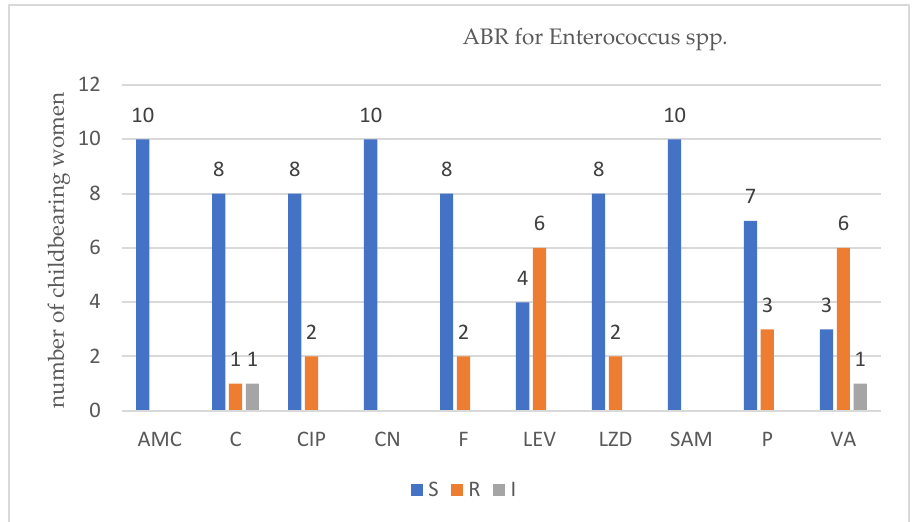
Figure 3. Profile of antibiotic resistance for Enterococcus spp.; S = sensitive, I = intermediate; R = resistant. Legend: ampicillin/sulbactam (SAM), amoxicillin/clavulanic acid (AMC), ciprofloxacin (CIP), chloramphenicol (C), gentamycin (CN), levofloxacin (LEV), linezolid (LZD), nitrofurantoin (F), penicillin (P), and vancomycin (VA).